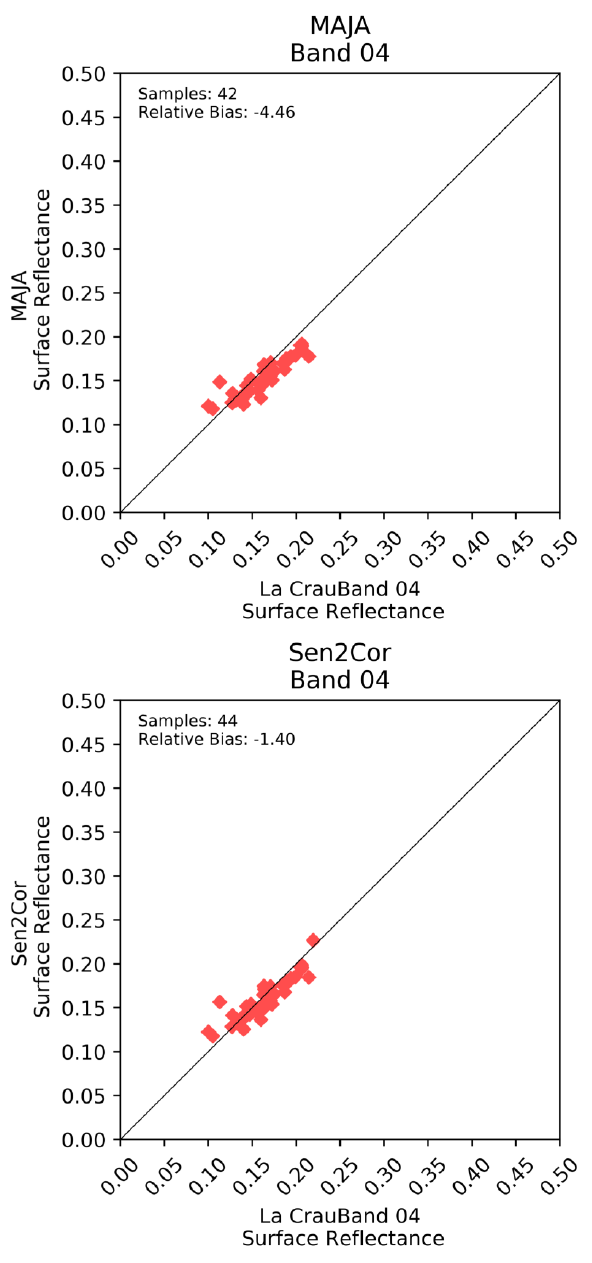
Figure 5. Surface reflectance validation over La Crau for Sentinel-2 band B8, results are